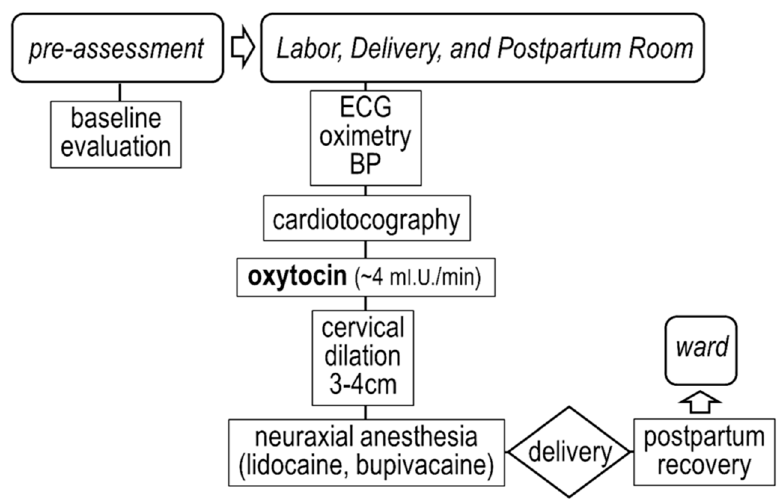
Figure 2. Vaginal delivery protocol at our Institution.